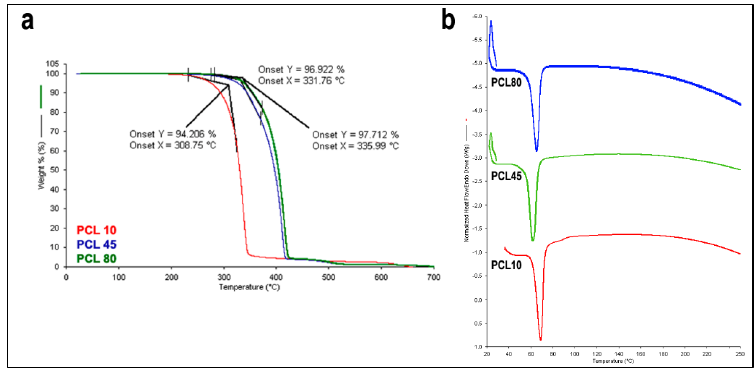
Figure 4. ( a ) TGA ( b ) DSC thermograms of PCL derivatives.